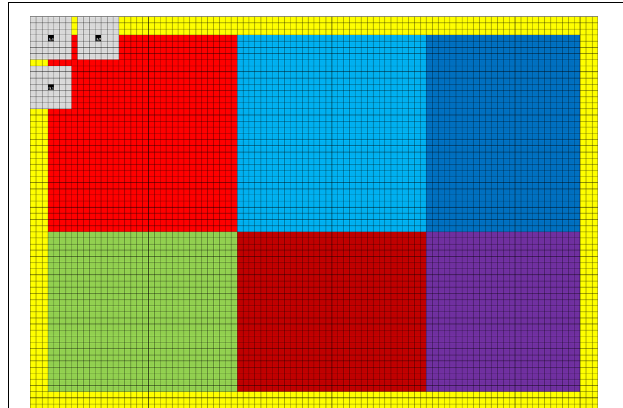
FIGURE 2 | The grid represents 96 × 64 pixels in local memory (each square is one pixel). As 32 x 32 threads are used per thread block, each thread needs to read 6 values from global memory into local memory [(96 × 64)/(32 × 32) = 6]. A yellow halo needs to be loaded into local memory to be able to calculate all the filter responses. In this case 90 × 58 valid filter responses are calculated, making it possible to apply at most a filter of size 7 × 7. The 90 × 58 filter responses are calculated as 6 runs, the first 2 consisting of 32 × 32 pixels (marked light red and light blue). The 1024 filter responses (32 × 32) are calculated in parallel, and the gray squares represent three filter responses being calculated. Note that neighboring filter responses are calculated using mainly the same pixels. Three additional filter responses are calculated in blocks of 32 × 26 or 26 × 32 pixels (marked green, dark blue and dark red). Finally, a block of 26 × 26 pixels is processed (marked purple). The halo can easily be changed to handle larger